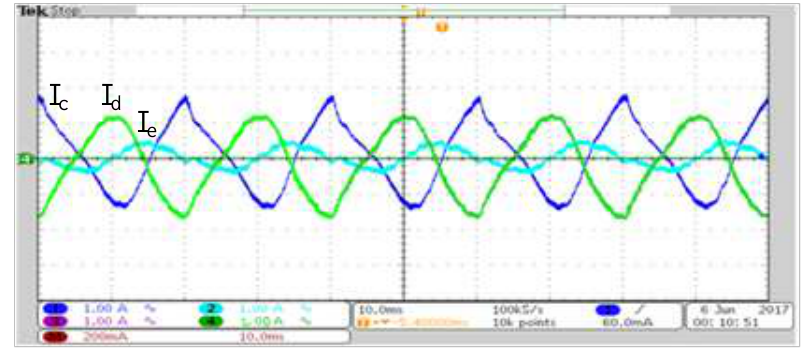
( d ) Line current in amp (Scale: 1 A/div, 10 ms/div)